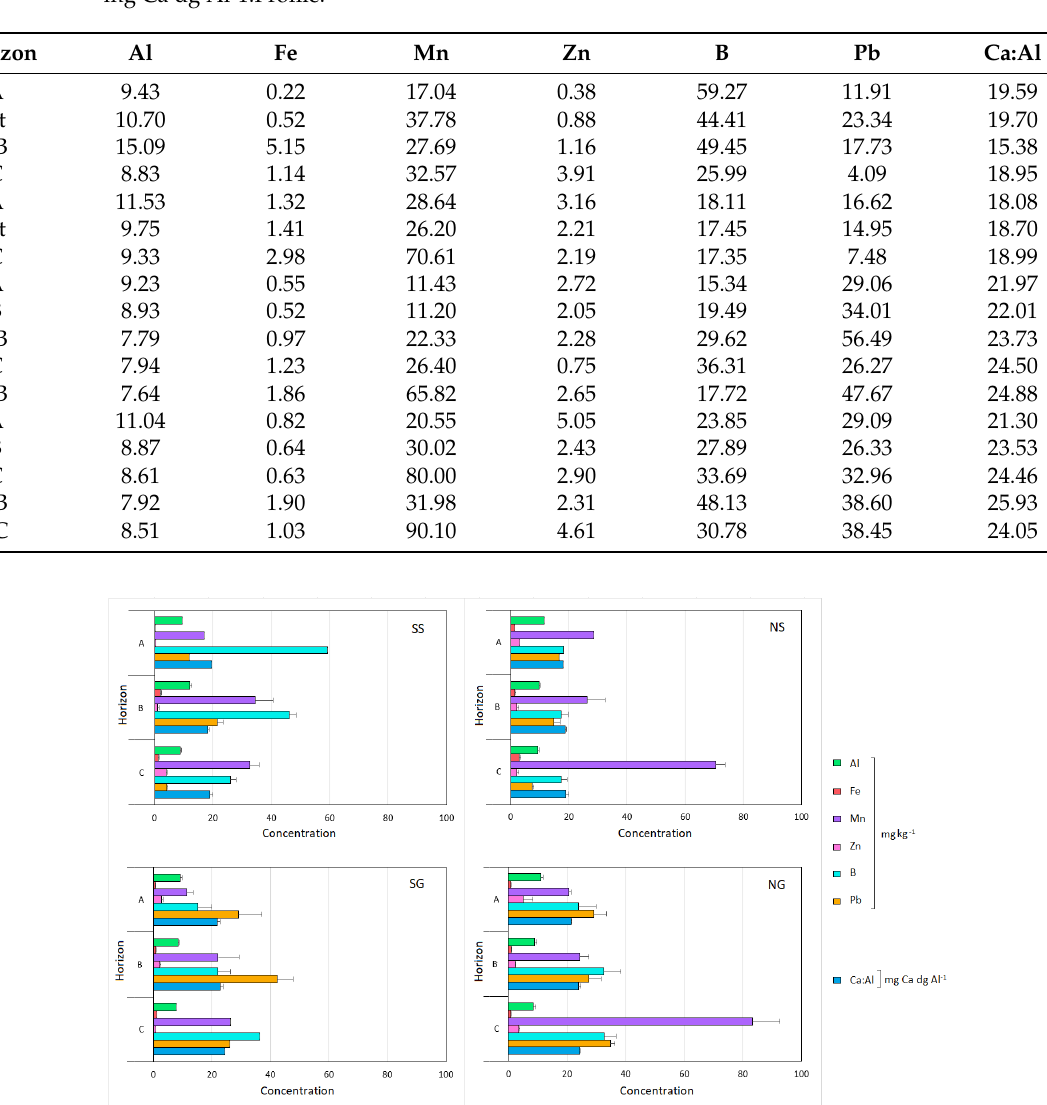
Table 1. Mean concentration of the minor soil elements in different studied horizons of the analysed soil profiles (SS, NS, SG, and NG). Al, Fe, Mn, Zn, B, and Pb are expressed in mg kg ‐ 1, and Ca:Al in mg Ca dg Al ‐ 1.Profile.